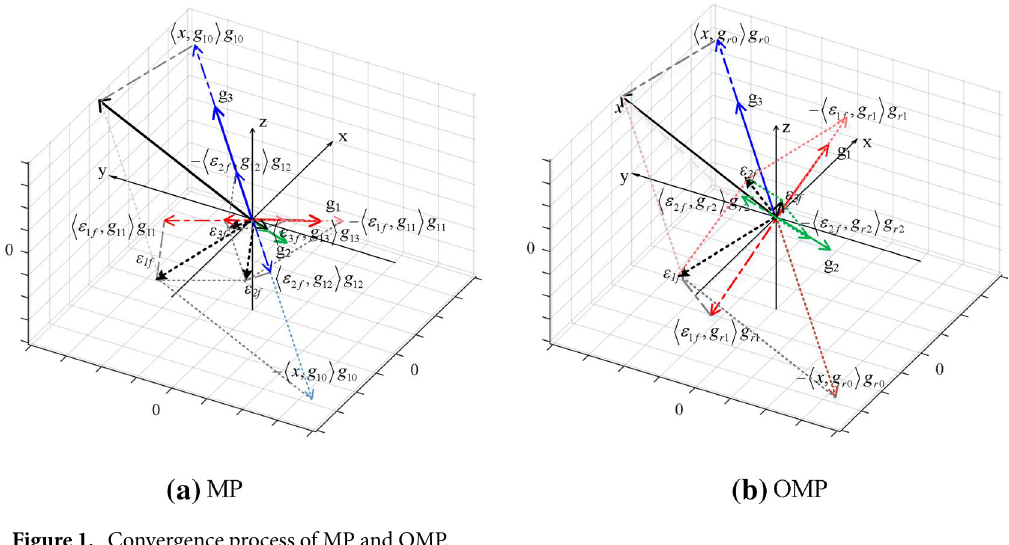
Figure 1. Convergence process of MP and